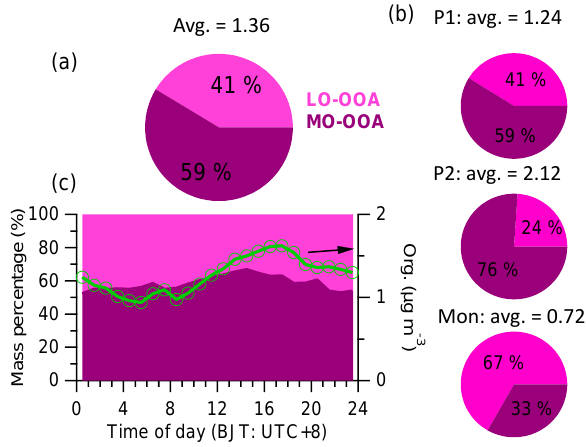
Figure 11. (a) The average mass contributions of two factors (a) during the study, (b) during the different periods, and (c) the diurnal mass contribution of two factors (left axis) accompanying the total organics (right